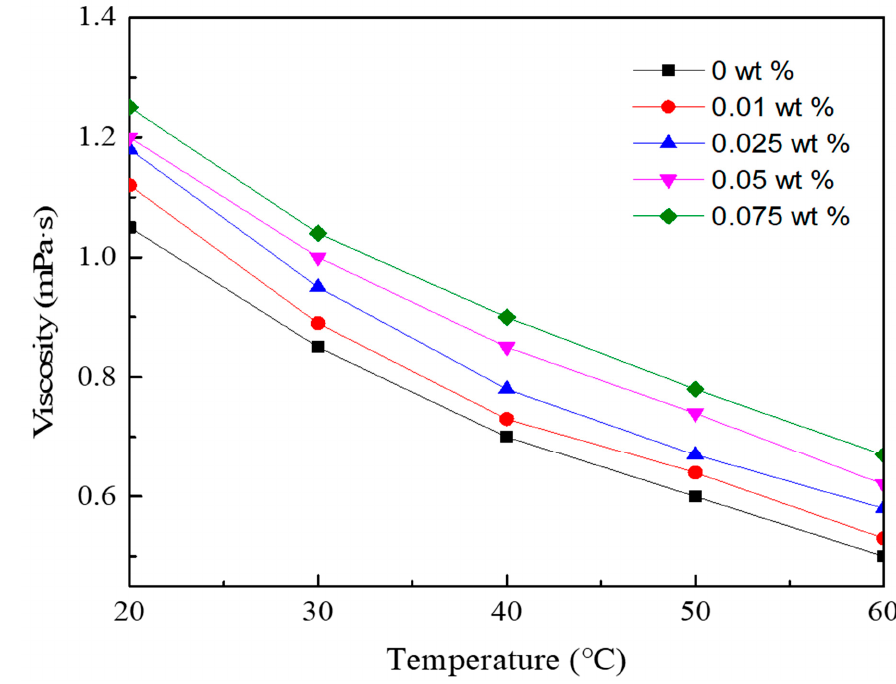
Figure 4. Viscosity of graphene/water nanofluid with various GNPs concentrations at different temperatures. The relationship between the viscosity ratio and GNPs concentration of nanofluid at different temperatures was fitted and represented by correlation equation (Equation (4)). The mean deviation between the calculated results of Equation (4) and measuring results is ±